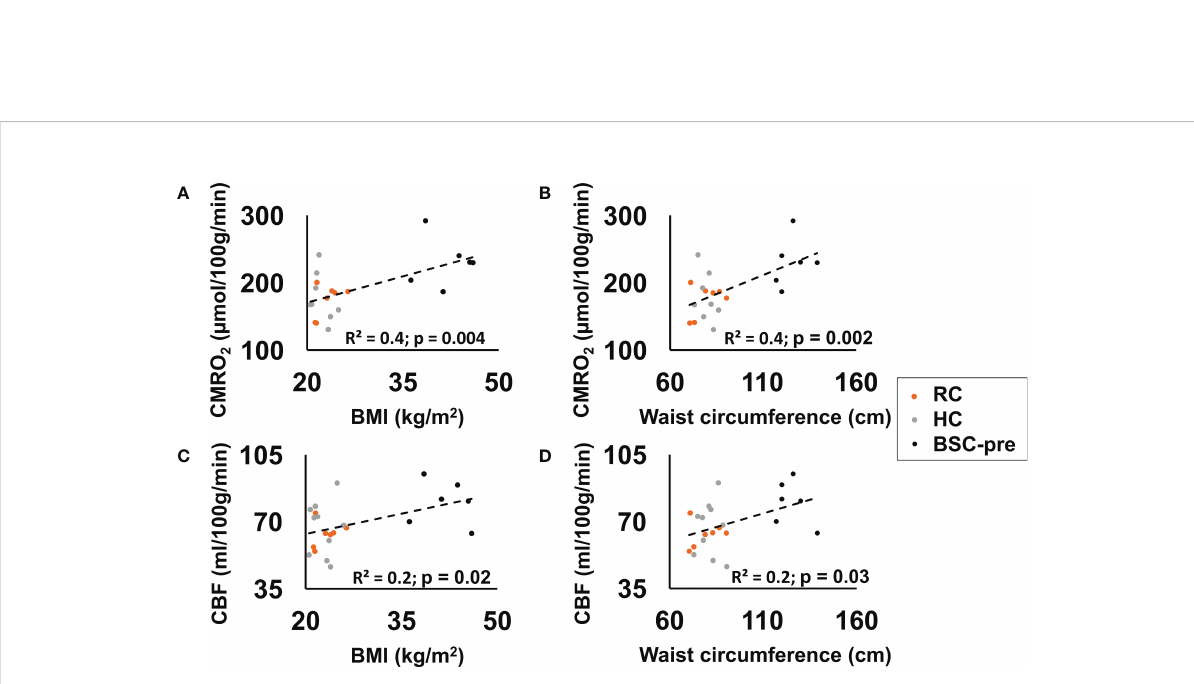
FIGURE 3 CMRO2 (p=0.004) (A) and CBF (p=0.02) (C) correlated signi fi cantly with BMI (reference control - RC, healthy normal weight controls - HC, bariatric surgery candidates at the pre-surgery stage - BSC-pre). CMRO2 (p=0.002) (B) and CBF (p=0.03) (D) correlated signi fi cantly with waist 7circumference.